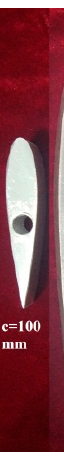
Figure 5. Blade model.